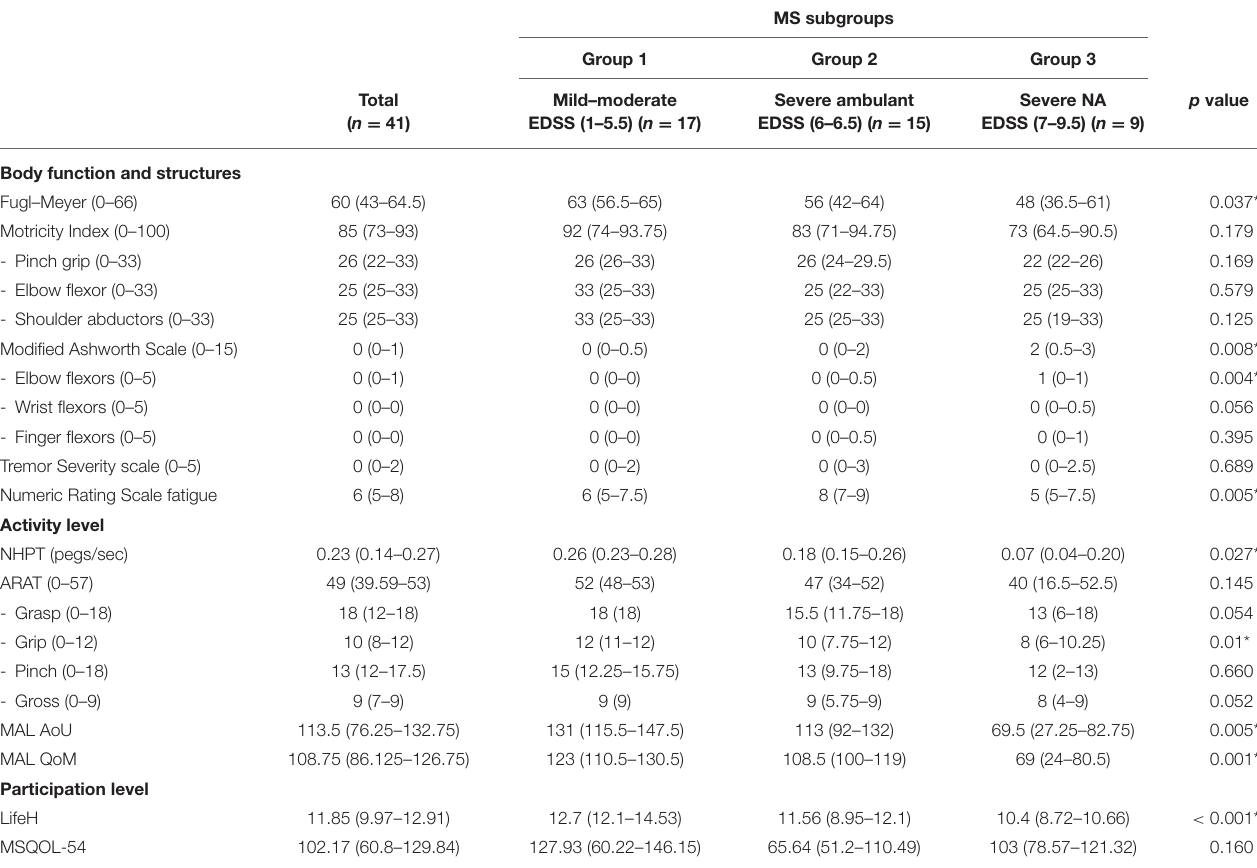
TABLE 2 | Median scores (25th /75th percentiles) of clinical variables and p values comparing the three